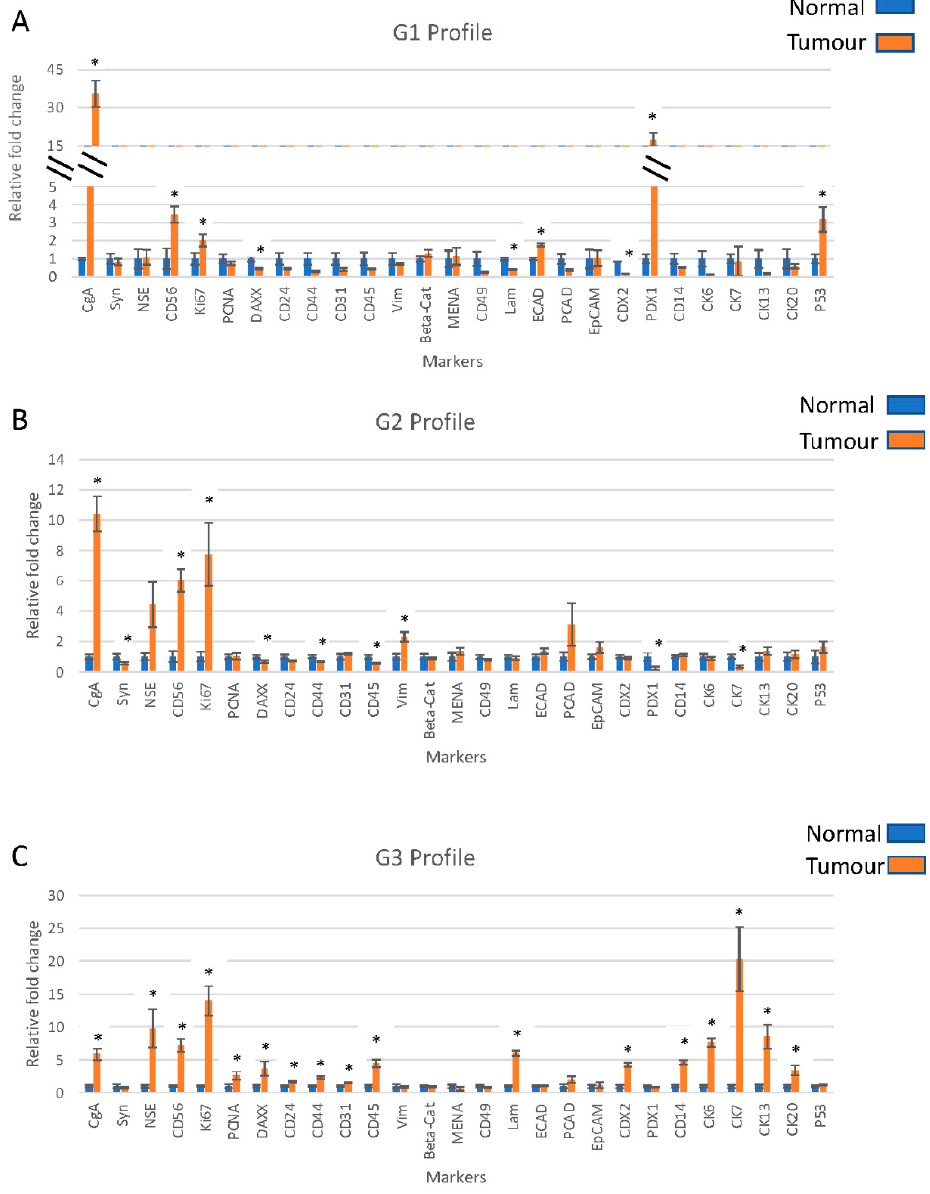
Figure 1. mRNA marker profiles for each of grade 1 ( A ), grade 2 ( B ) and grade 3 ( C ) pancreatic neuroendocrine tumours. These profiles were developed using the average expression of all the samples from each grade. All marker expressions were normalised to the matched non-tumour tissues and using β -actin as the endogenous control. * represents a statistically significant difference ( p < 0.05) in the marker expression in the tumour relative to that in non-tumour.